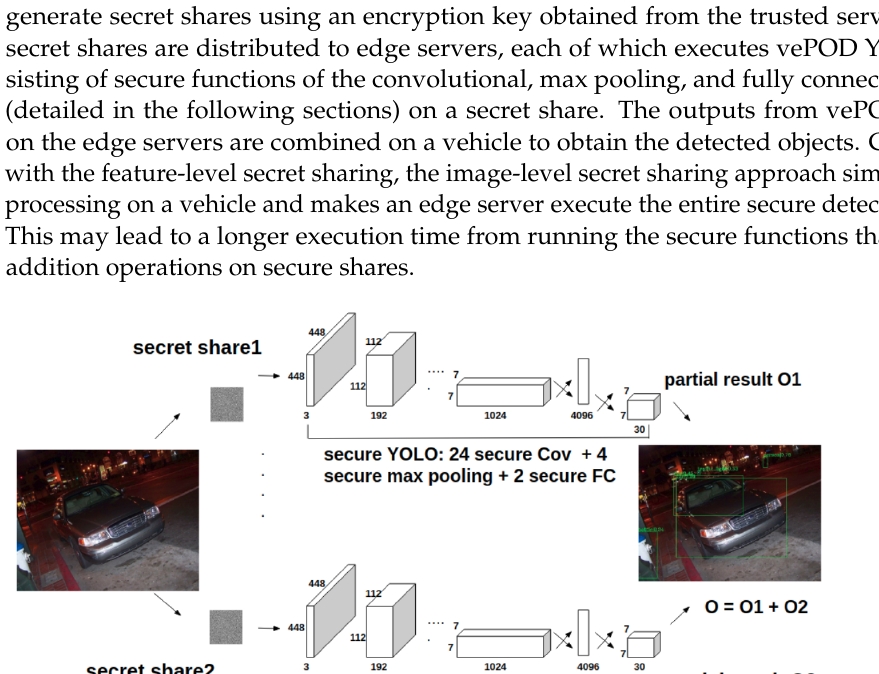
Algorithm 2 sketches the secure function for map pooling. In a vehicle–edge comput- ing environment with two edge servers, secure map pooling works as